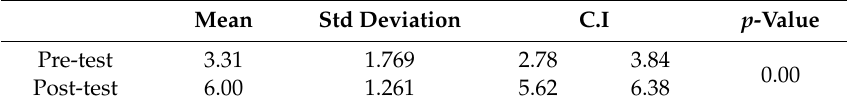
Table 4. Paired samples statistics: